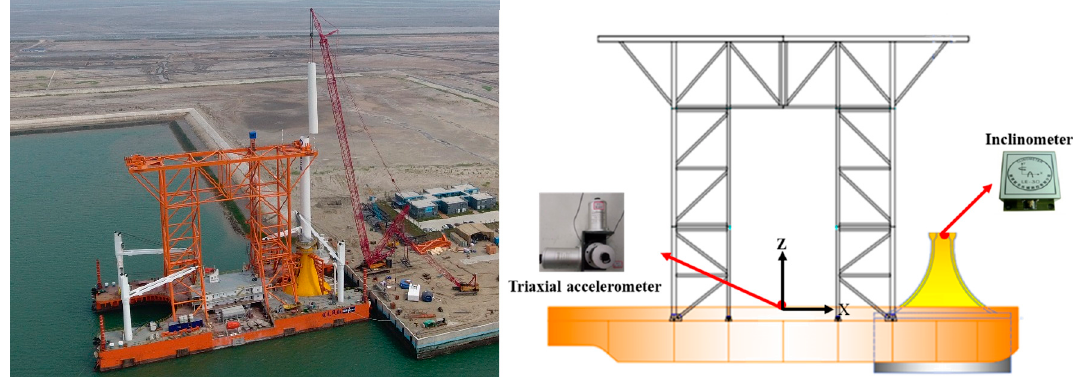
Figure 6. Hoisting process of tower at dock.